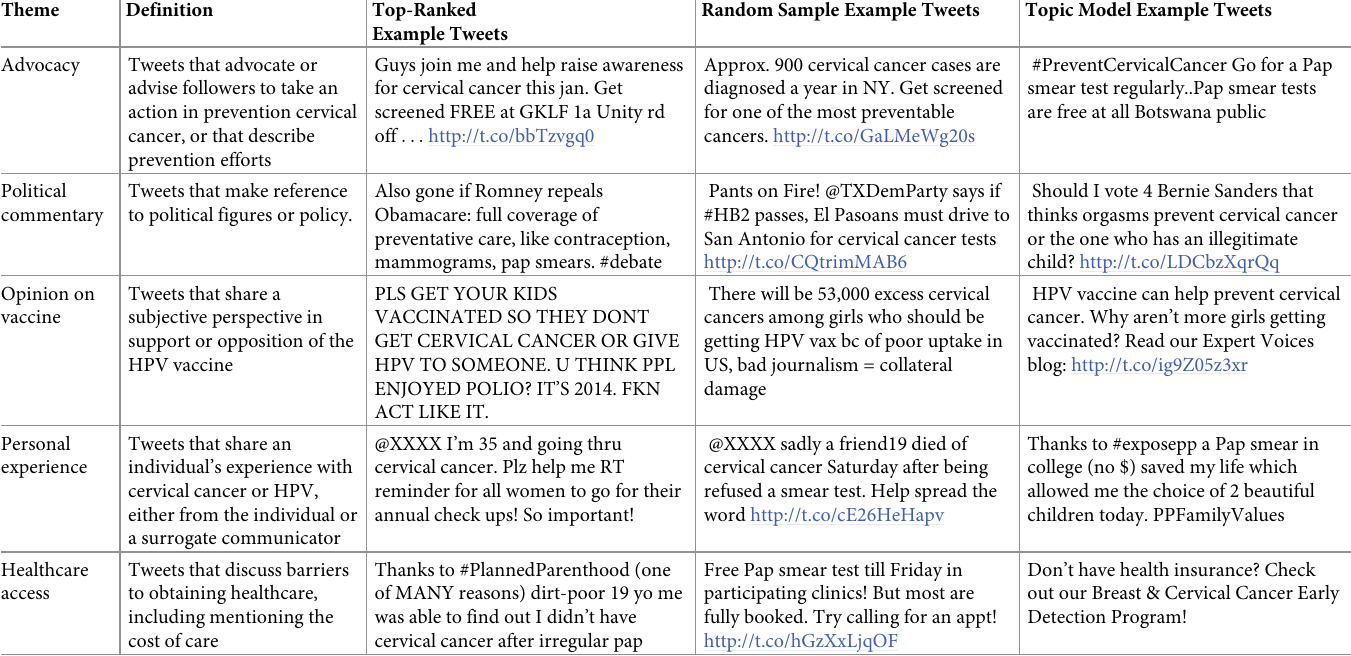
Table 1. Themes and example tweets by sample